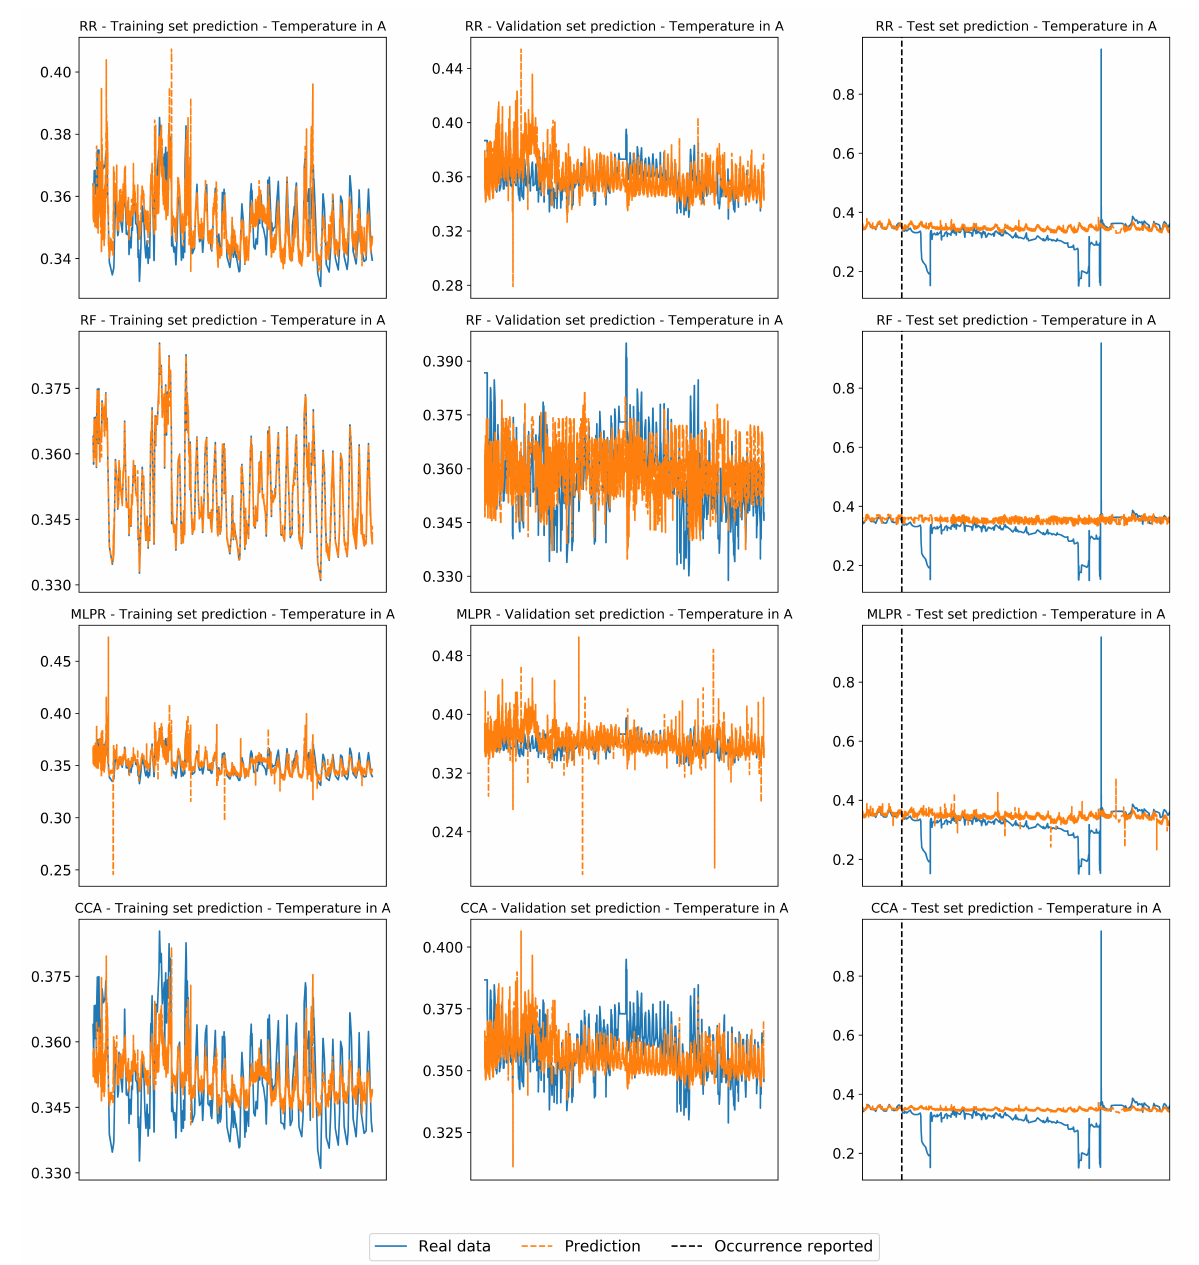
Figure 4. Regressors prediction for dimensionless Temperature in fiscal meter 02A (Section A) along Fault-FII when the PCStable algorithm (partial correlation) with MCI (conditional mutual information) was used as the variable selection